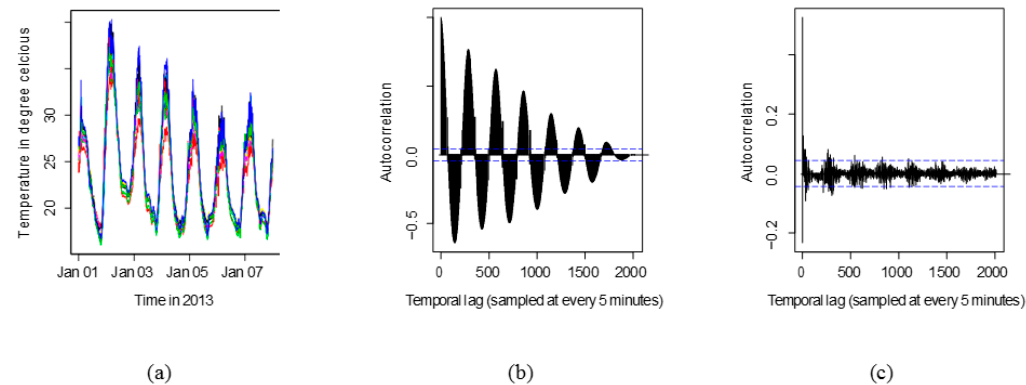
Figure 3. ( a ) Multiple time series plot for 12 nearby sensors; ( b ) Sample autocorrelation for a univariate temperature series; ( c ) Sample autocorrelation for differenced time series. Horizontal dashed lines indicate the +/ − 5% bounds normally used to identify stationarity in the ACF.